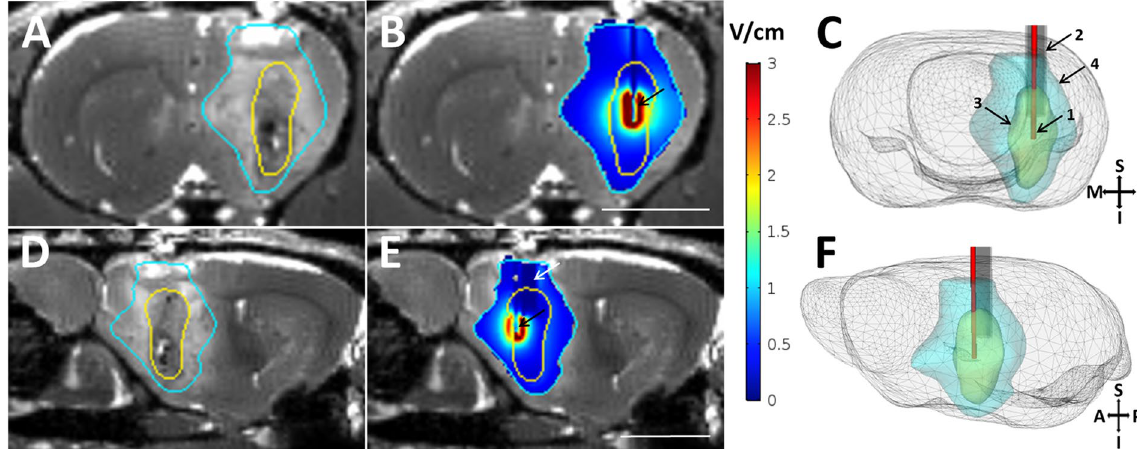
Figure 6. Image-based simulation of IMT electric fields. A 9.4T MRI system was used to generate true fast imaging with steady state precession (TrueFISP) images of a 7-day GBM tumor in the rodent brain. Coronal ( A , B ) and sagittal ( D , E ) images are shown. ( A , D ) Brainsuite software (v.16a1) was used to segment the tumor (yellow trace) and edema (turquoise trace). The segmented volumes were imported to COMSOL Multiphysics (v.5.2a), where the intratumoral bioelectrode and cannula geometries were simulated. ( B , E ) The conductance and dielectric values of the hardware (bioelectrode, black arrow; cannula, white arrow) and neural elements were used with the boundary condition of constant voltage amplitude of 2.0 V at 200 kHz for the bioelectrode and the reference electrode applied outside the skull. The resulting map of the electric field magnitude was exported and combined with the TrueFISP MR images for visualization in 3D Slicer (v.4.4.0). The electric field data within the tumor was analyzed using MATLAB R2015b to estimate the fraction of tumor receiving specific field amplitudes (see Fig. 7). Three-dimensional rendering of the rodent brain shown in ( C ) coronal and ( F ) oblique sagittal views depict the relationship between the 1) intratumoral bioelectrode, 2) cannula, 3) GBM mass and 4) region of tumor-associated cerebral edema. S, superior; I, inferior; M, medial; L, lateral; A, anterior; P, posterior. The scale bar in B corresponds to panels A and B; that in E to panels D and E; both depict 5 mm.